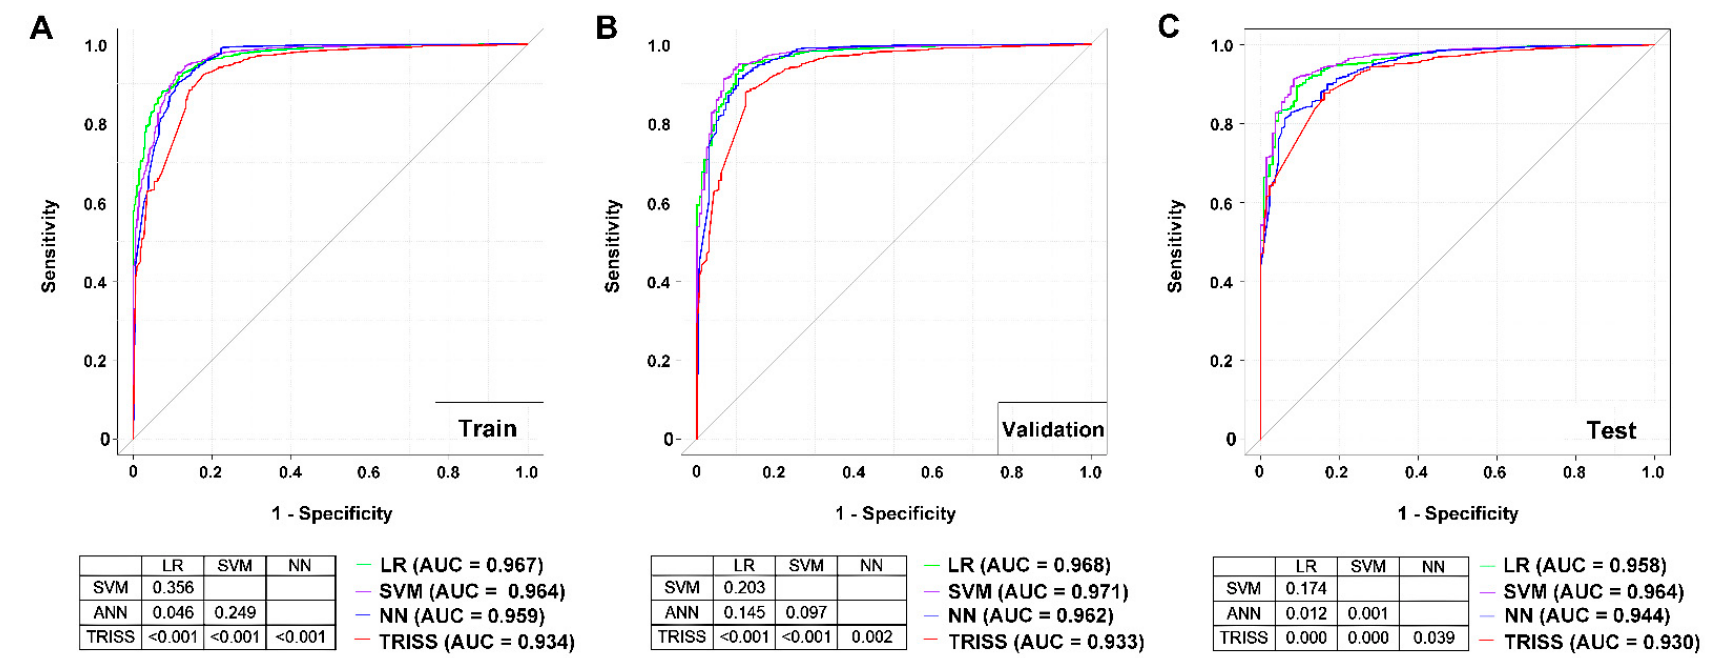
Figure 2. Receiver operating characteristic (ROC) curves for the LR, SVM, NN, and TRISS models in predicting the survival of trauma patients in the ( A ) train, ( B ) validation, and ( C ) test datasets.